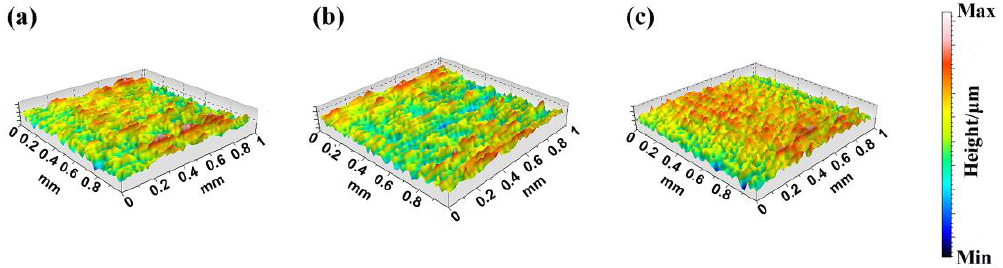
Figure 5. The 3D profile of the Ta coatings. ( a ) 200 °C-175 W, ( b ) 300 °C-150 W, and ( c ) 400 °C-100 W. Table 3. Height parameters of the Ta coatings in different conditions.